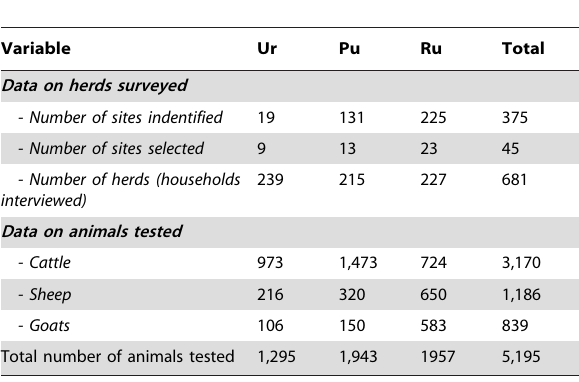
Table 1. Total number of herds surveyed and animals tested in the urban (Ur), peri-urban (Pu) and rural areas (Ru) of Niger.